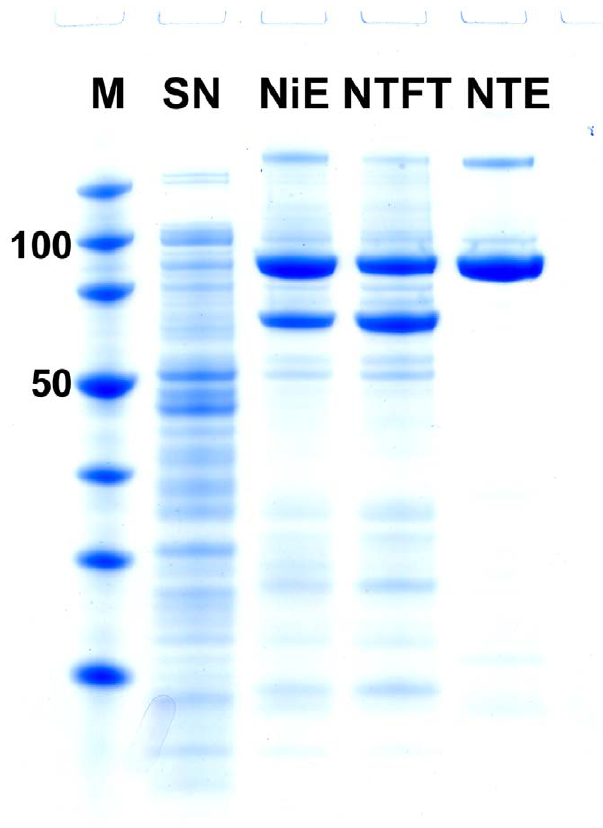
Figure 1. Purification of NTS1. The progress of purification was monitored by SDS-PAGE (NuPAGE 4–12% Bis-Tris gel, Invitrogen, 1 6 MES SDS buffer) and SimplyBlue staining. Lane M: Novagen Perfect Protein Marker (15–150 kDa); lanes SN, NiE and NTFT: 5 m g of protein per lane; lane NTE: 3 m g of protein. Abbreviations are as in Table 3.